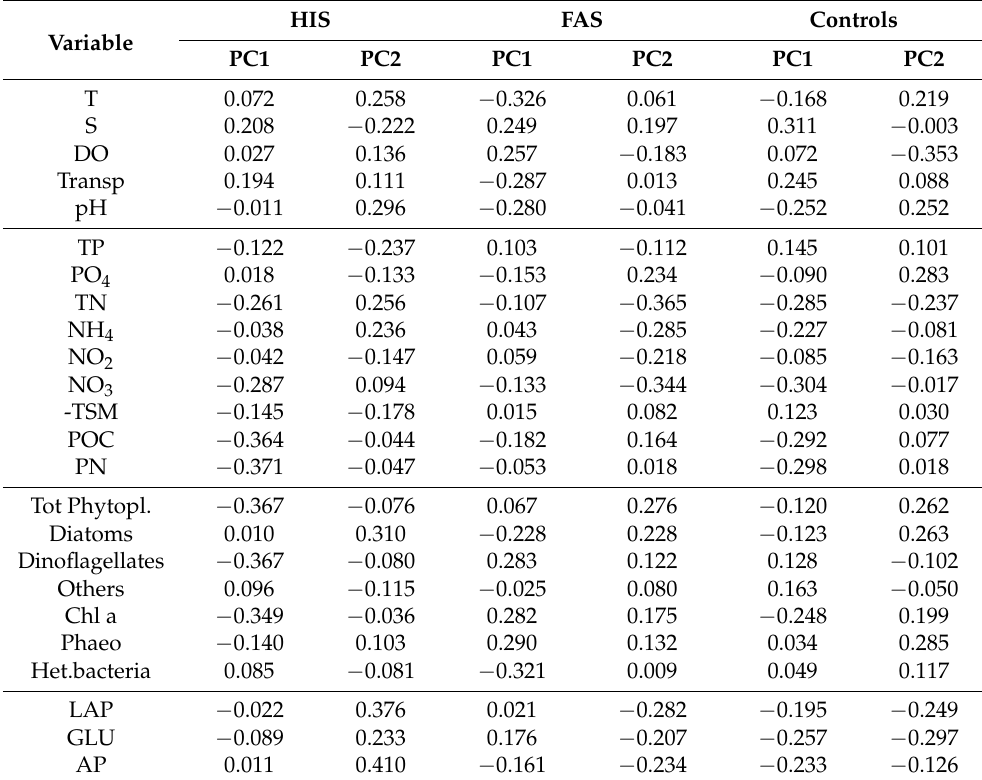
Table 5. Eigenvectors values showing the relative contribution of each parameter to Principal Components at human-impacted stations (HIS), freshwater-affected stations (FAS) and control stations